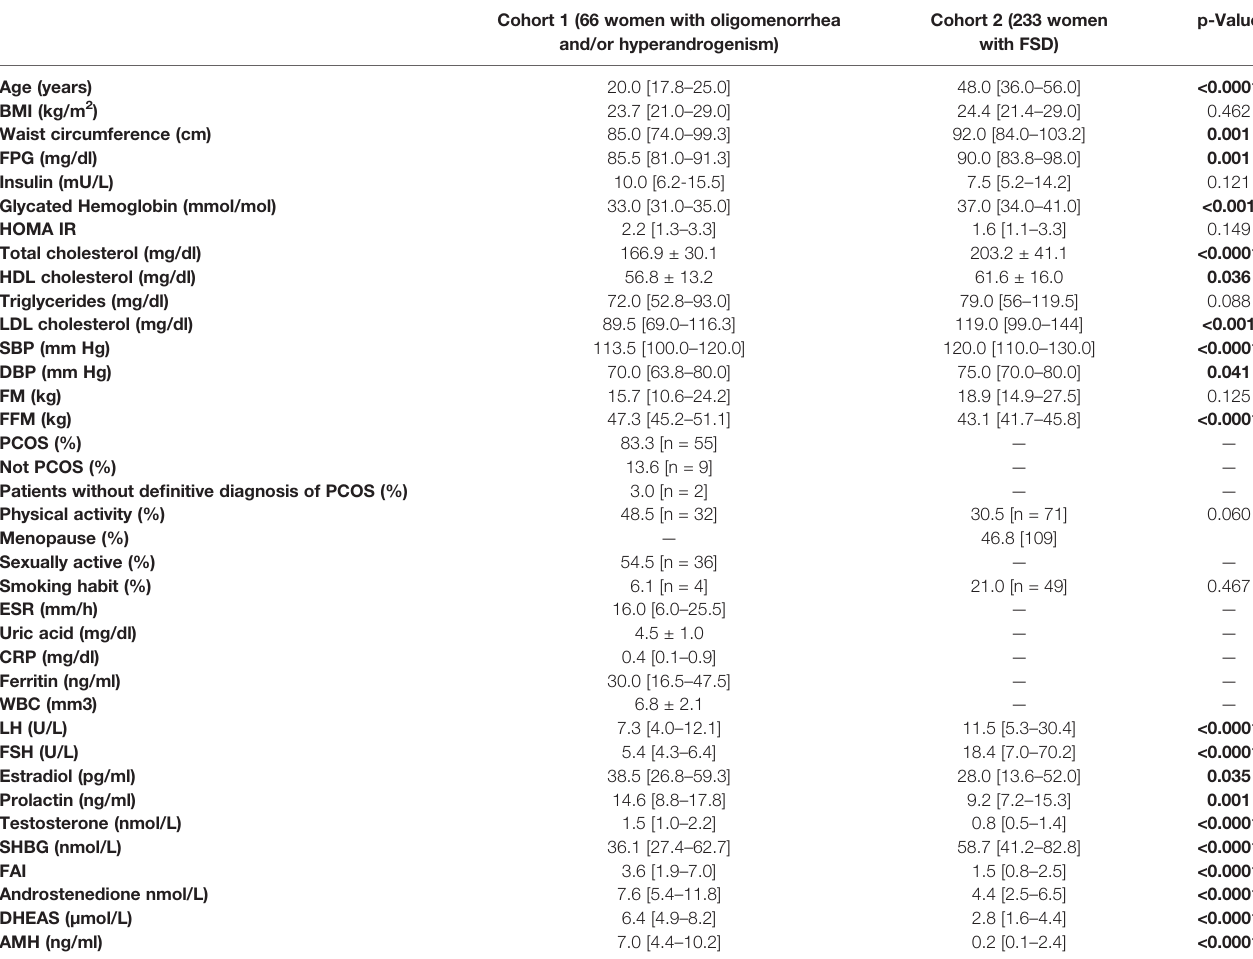
TABLE 1 | Characteristics of the two samples.